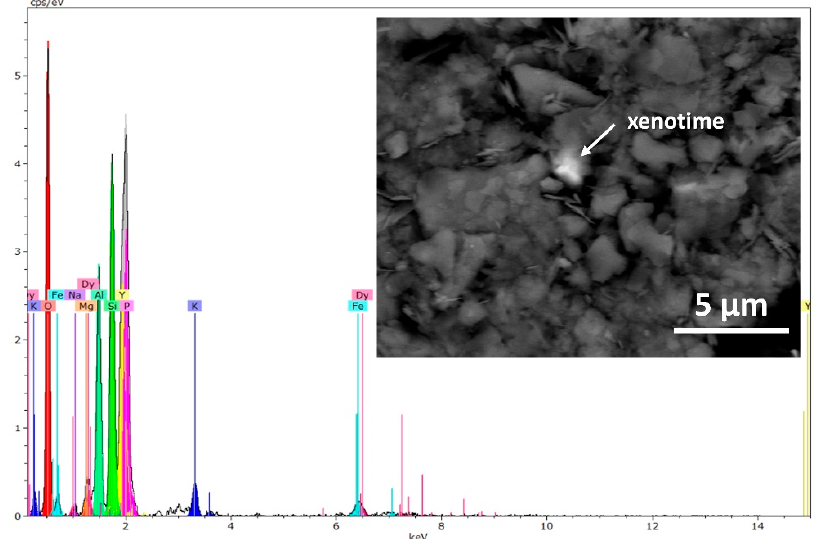
Figure A3. Spectral plot and Backscattered Electron (BSE) image of a HREE-bearing xenotime identified on dust filter T309 by EDXS trace mineralogy analysis.